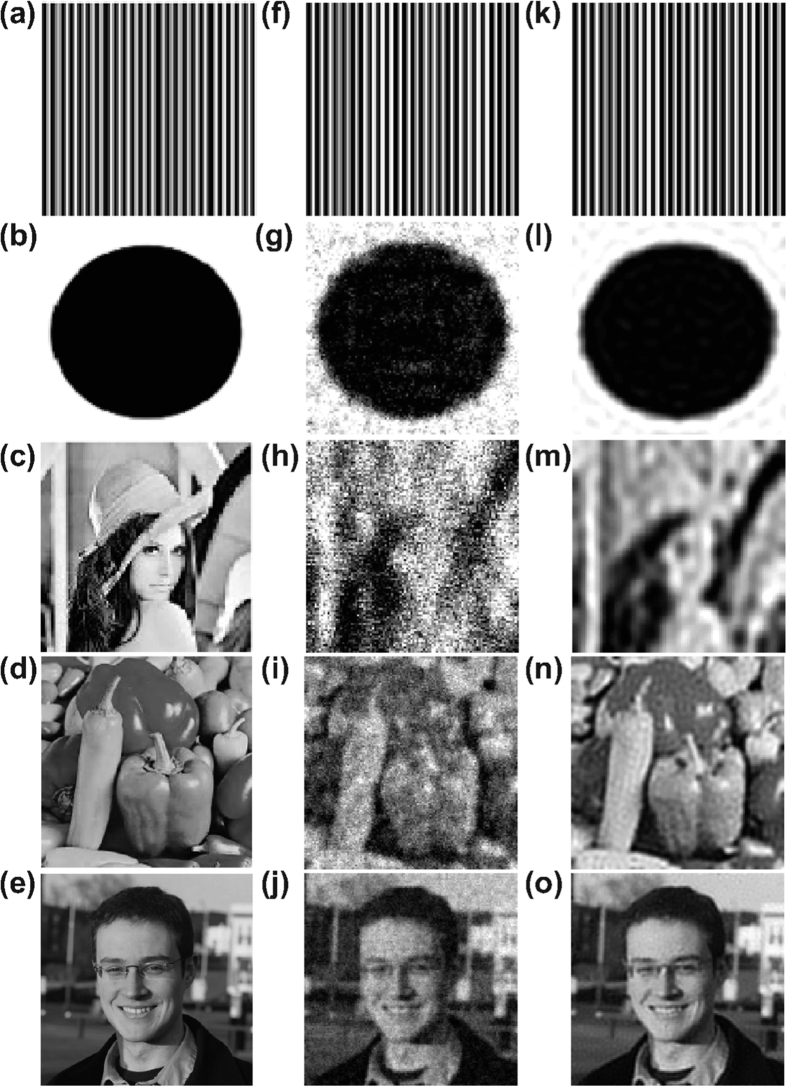
Reconstruction comparison.(a–c) 1002, (d) 2502, (e) 4002 pixel images. (f–j) Uniformly-random sampling CS reconstructions. (k–o) Localized random sampling CS reconstructions. For each n2 pixel image, reconstructions use m = n2/10 sampling units. The relative reconstruction errors via uniformly-random sampling are 1.0 × 10−14, 0.26, 0.40, 0.22 and 0.12 for (f–j). The relative reconstruction errors via localized random sampling are 1.3 × 10−15, 0.14, 0.21, 0.10, and 0.05 for (k–o). Courtesy of the Signal and Image Processing Institute at the University of Southern California.